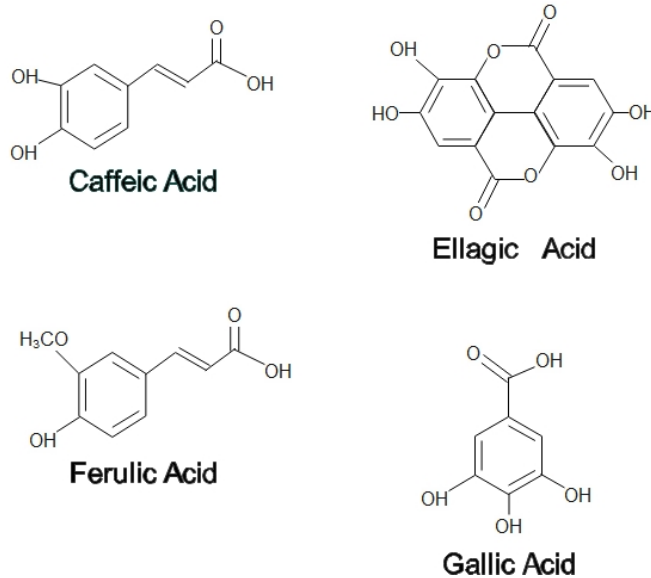
Figure 2. Phenolic acids in honey and propolis.